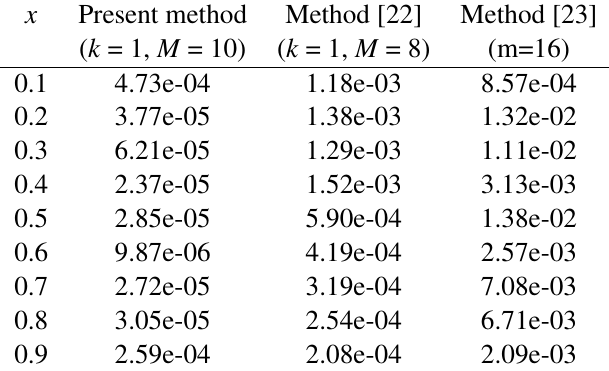
Table 3 Error analysis of example